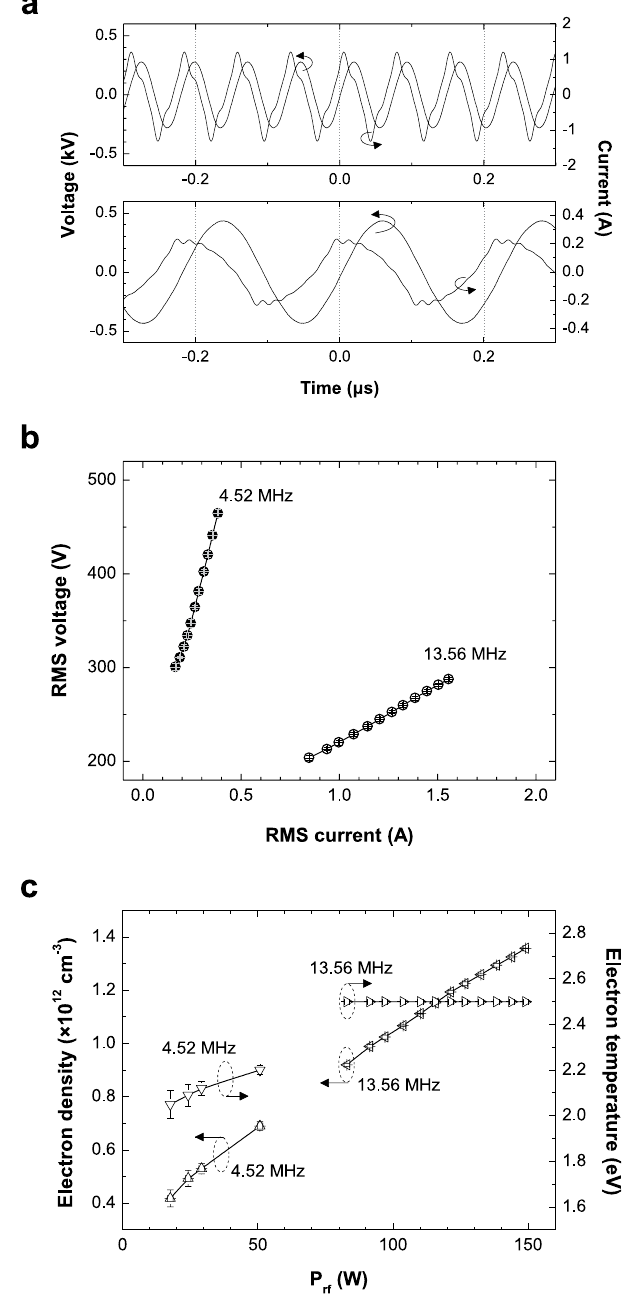
Figure 1. Electrical and electron characteristics of single-rf argon capacitive discharges. ( a ) Typical discharge voltage and current waveforms of 13.56 MHz (top) and 4.52 MHz (bottom); ( b ) I RMS - V RMS characteristics of single-rf-driven discharges at 13.56 MHz and 4.52 MHz; and ( c ) n e and T e as a function of rf power coupled to the plasma. Data in b and c are shown as the mean ± s.d. for all panels; n = 5. The error bar of the x -axis data corresponds to the difference between the input rf power and dissipated rf power or I RMS